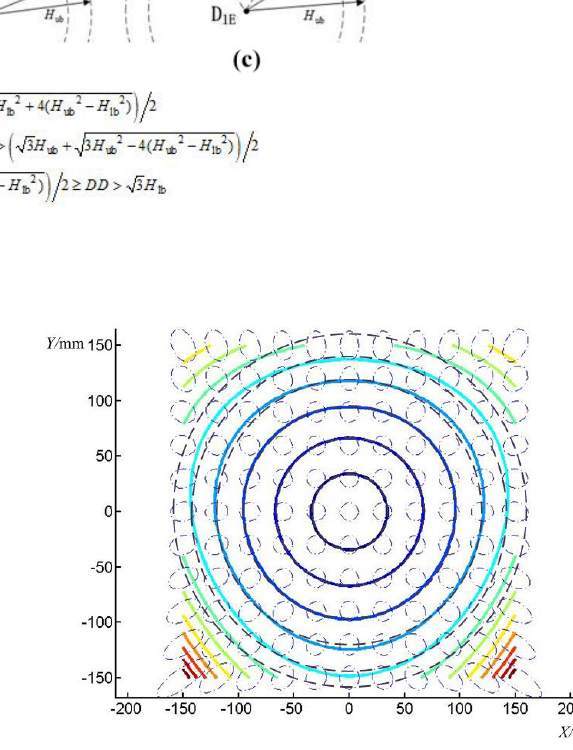
Figure 12. Stiffness contours of the platform in case